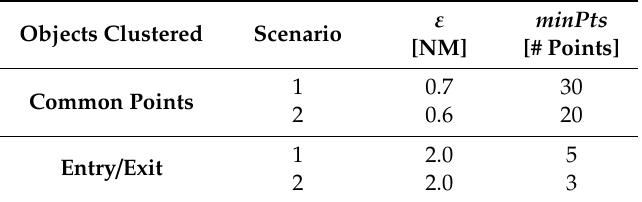
Table 1. Parameter sets for the DBSCAN algorithm.